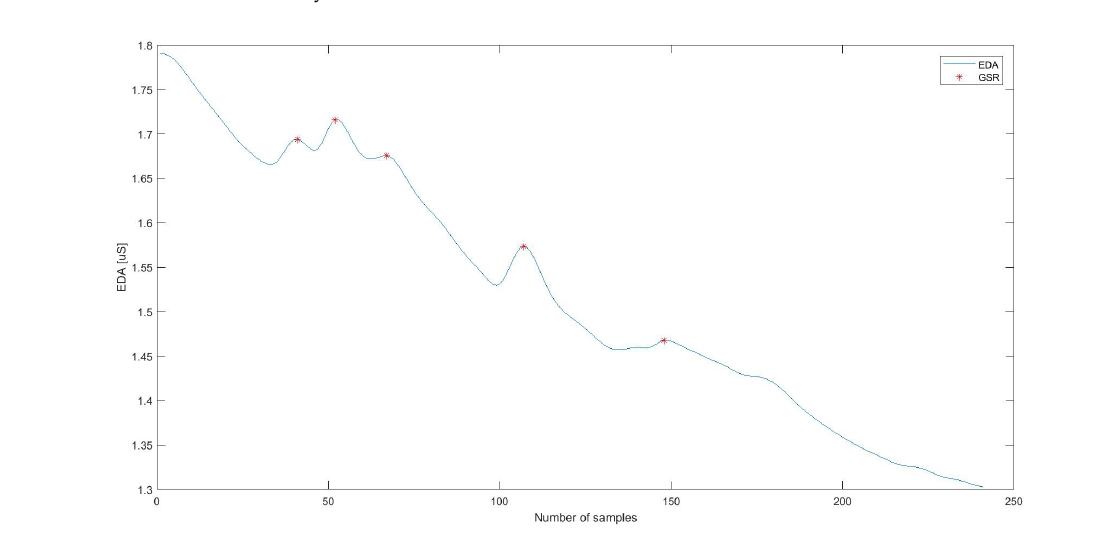
Figure 5. Example of the Electrodermal Activity signal (EDA) with Galvanic Skin Response